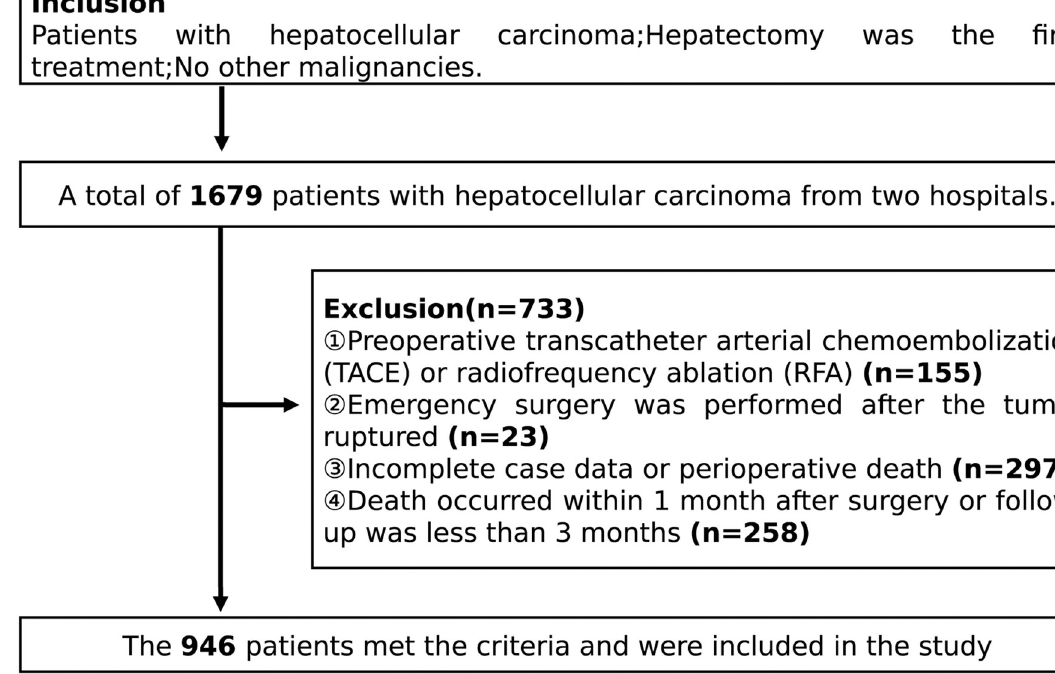
Fig 1. The flow of study